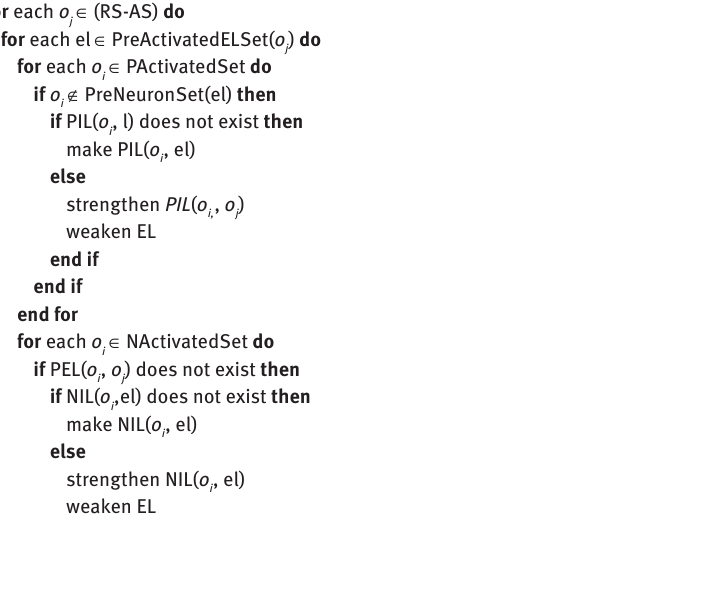
Algorithm 4: Neural Network Adjusting for Case